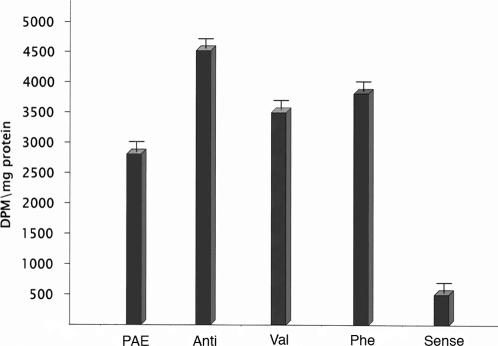
Quantitation of the extent of protein deamidation in cells lysates after oxidative stress.Cells transfected with PCMT wild type (sense), antisense PCMT (anti), PCMT mutants [Asp83 →Phe83 (Phe) and Asp83→Val83 (Val)] and endothelial cells transfected with void plasmid (PAE) were stressed with 0.3 mM of H2O2. Deamidated proteins were quantitated in each lysate preparation using recombinant PCMT. Standard deviation error bars are included for each analysis.